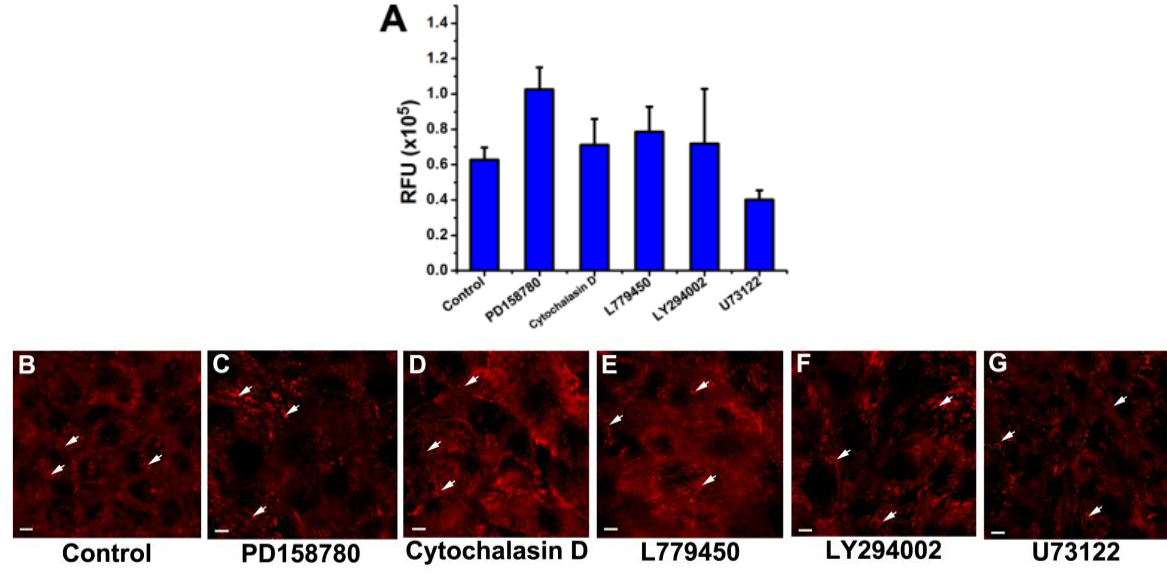
Figure 2. Fluorescence images of immunostained vinculin within focal adhesions of mutant MCF10A cells in response to 10 nM EGF. Examples of focal adhesions are indicated with arrows. Scale bar: 10 µm. The cells had been pretreated with an inhibitor described in (B–G). ( A ) Quantitation of the areal densities of stained vinculin in relative fluorescence units (RFU) as a measure for the level of focal adhesions (mean ± SEM; n = 10) in (B–G). ( B ) The control without the presence of an inhibitor. ( C ) 100 nM PD158780. ( D ) 1 µM cytochalasin D. ( E ) 10 µM L77945. ( F ) 10 µM LY294002. ( G ) 5 µM U73122. The difference in fluorescence intensities between the control and each inhibited sample is significant as indicated by P < 0.001 for all five inhibited